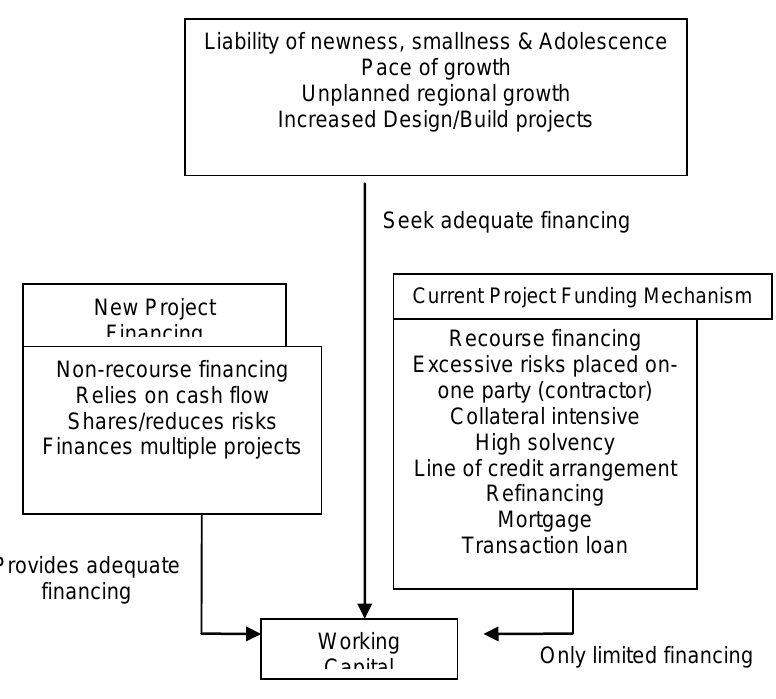
Figure 1 : Project financing problems for small